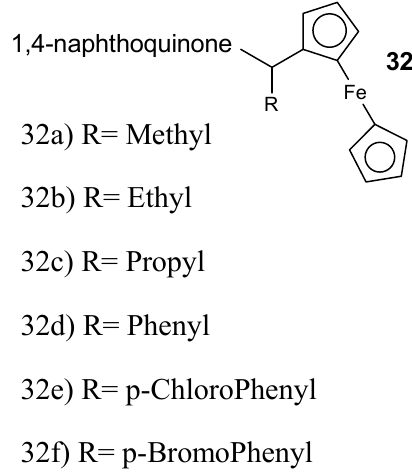
Figure 16. Structure of 3-ferrocenylmethyl-2-hydroxy-1,4-naphthoquinone 32a – f.